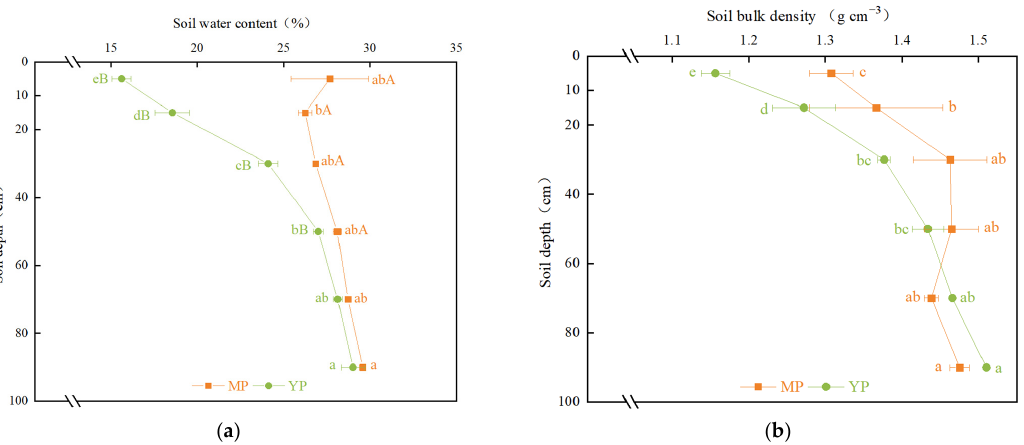
Figure 2. Changes of soil water content ( a ) and soil bulk density ( b ) along 0 − 100 cm soil profiles in the mature (MP) and young poplar (YP) plantations. Different lowercase letters denote significant differences among different depths within the same plantation; while different uppercase letters denote significant differences between different plantations within the same soil depth ( p <